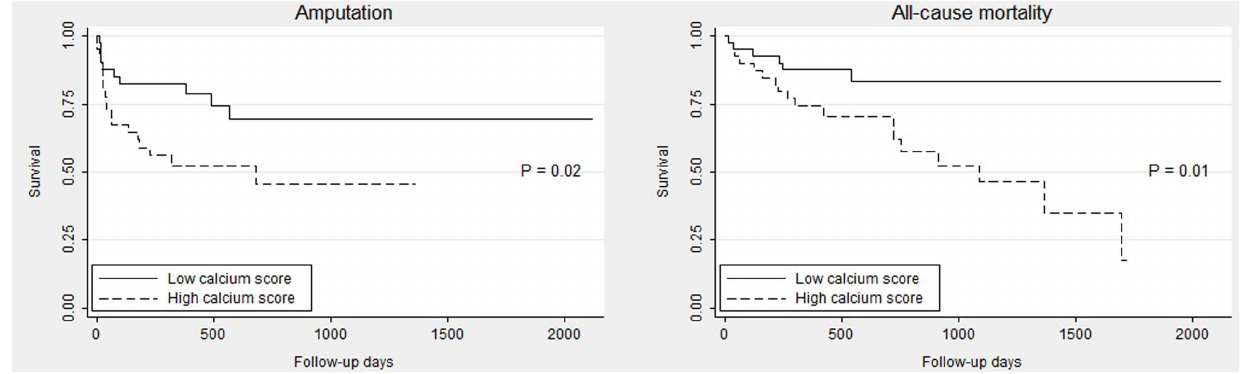
Figure 2. Kaplan-Meier survival curves for amputation and all-cause mortality according to lower extremity arterial calcium scores with the median as cutoff value in patients with symptomatic peripheral artery